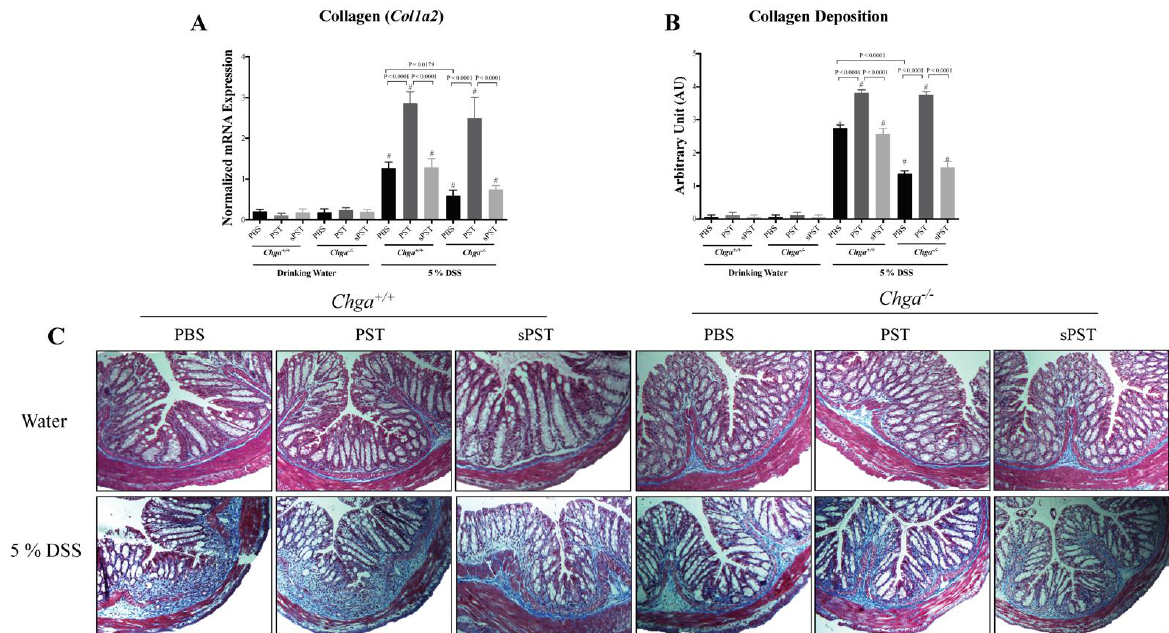
Figure 3. Pancreastatin (PST) promotes collagen expression and deposition in the colon during dextran sulfate sodium (DSS)-induced colitis. C57BL/6 background wild-type ( Chga +/+ ) and CHGA-knockout mice ( Chga − / − ) were given 5% DSS solution in their drinking water for five days to induce colitis. Control mice received water without DSS. PST or scrambled peptide (sPST) (2.5 mg/kg/day, intrarectal) and 1% phosphate buffer saline (1% PBS) treatment started one-day before induction of colitis. Colonic collagen deposition scores were quantified by ( A ) quantitative real-time RT–PCR in mRNA expression of collagen col1a2 or ( B , C ) Masson trichrome (100×), whereas collagen was stained in blue. The relative mRNA expression was determined by calculating the difference in the threshold cycle (ΔCt) method. One-way ANOVA followed by multiple comparison tests. Each value represents the mean ± SEM, n = 8–10 mice/group. # refers to significance compared with control groups (drinking water) .